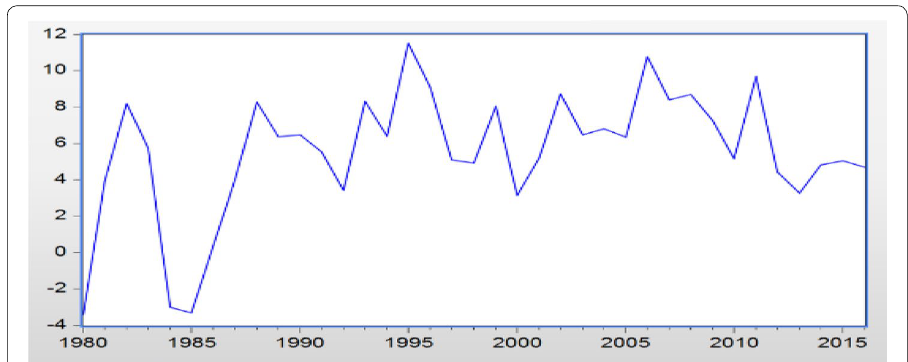
Fig. 2 Uganda’s Economic Growth, 1980–2016 (Source: World Bank)